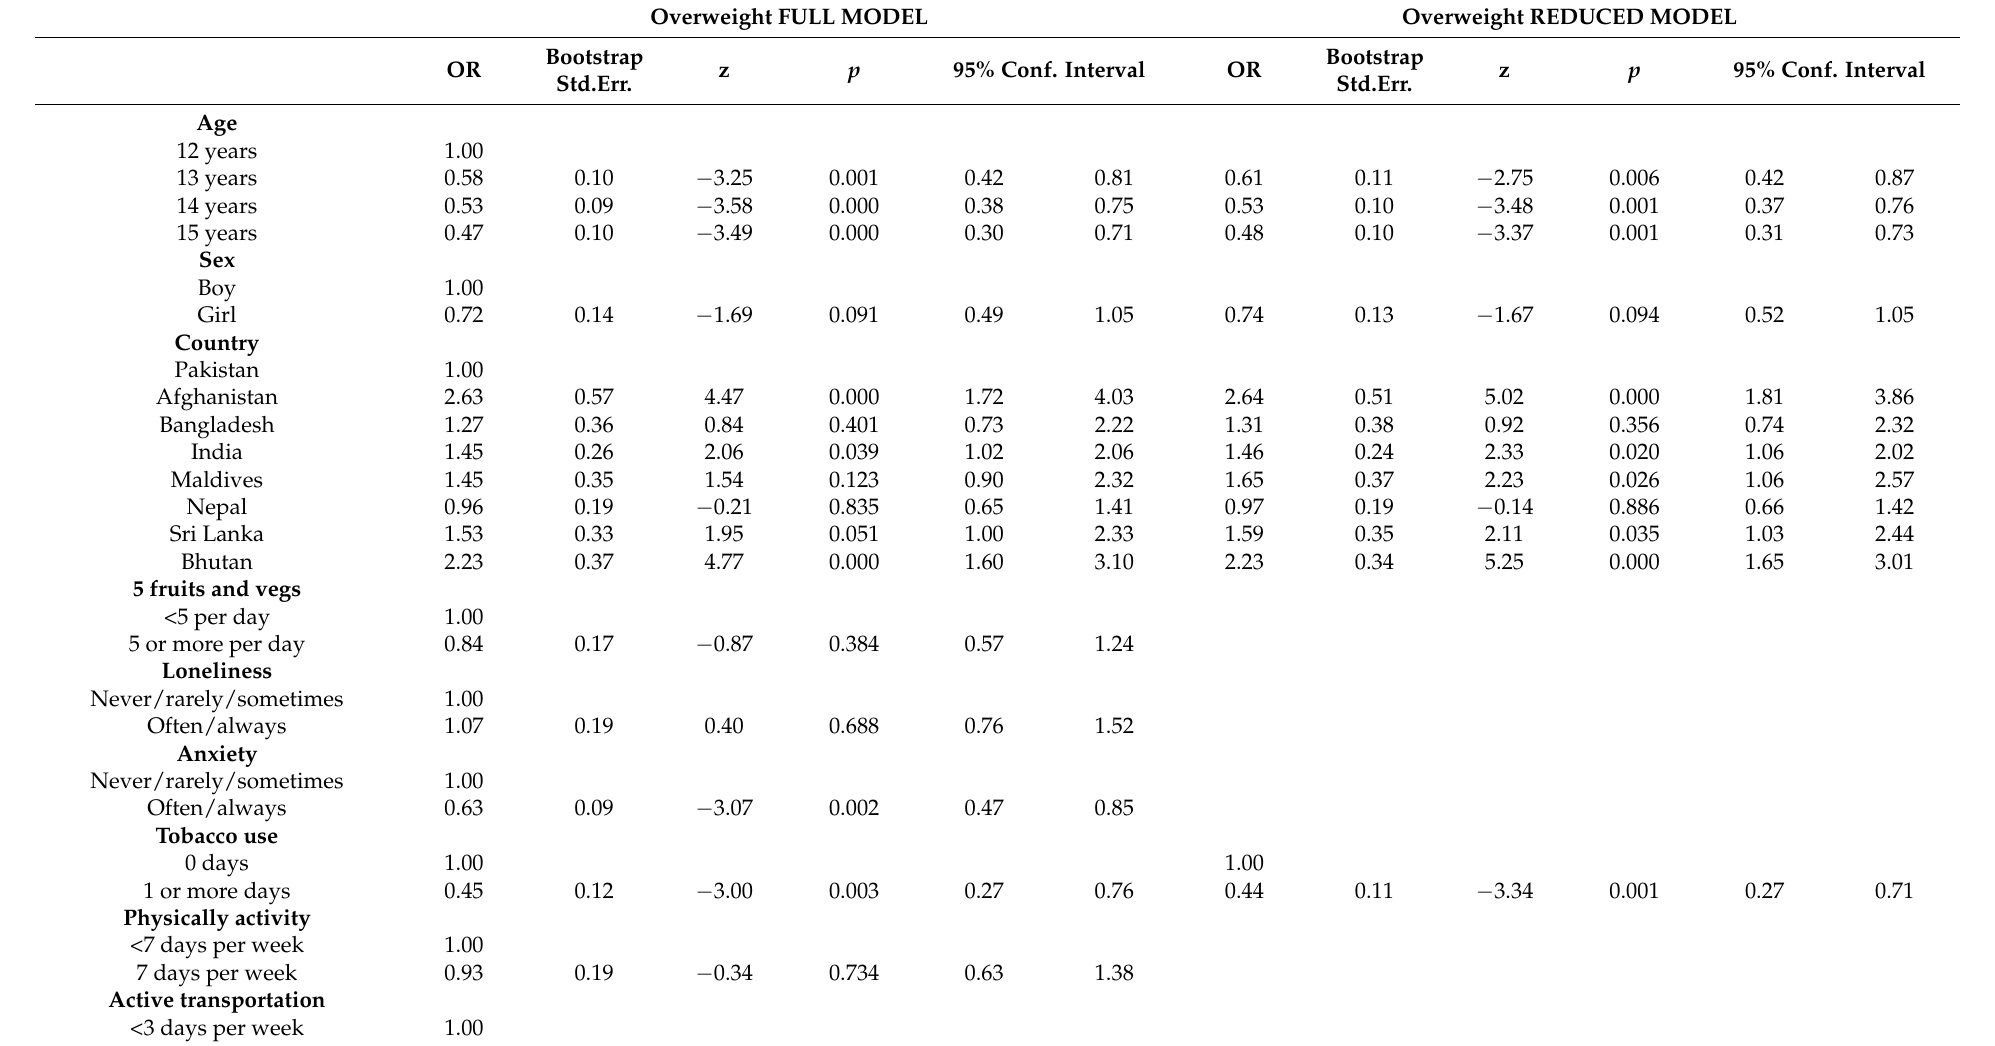
Table 8. Multivariable logistic regression model for adolescent overweight in South Asia, GSHS datasets. Overweight FULL MODEL Overweight REDUCED MODEL Bootstrap